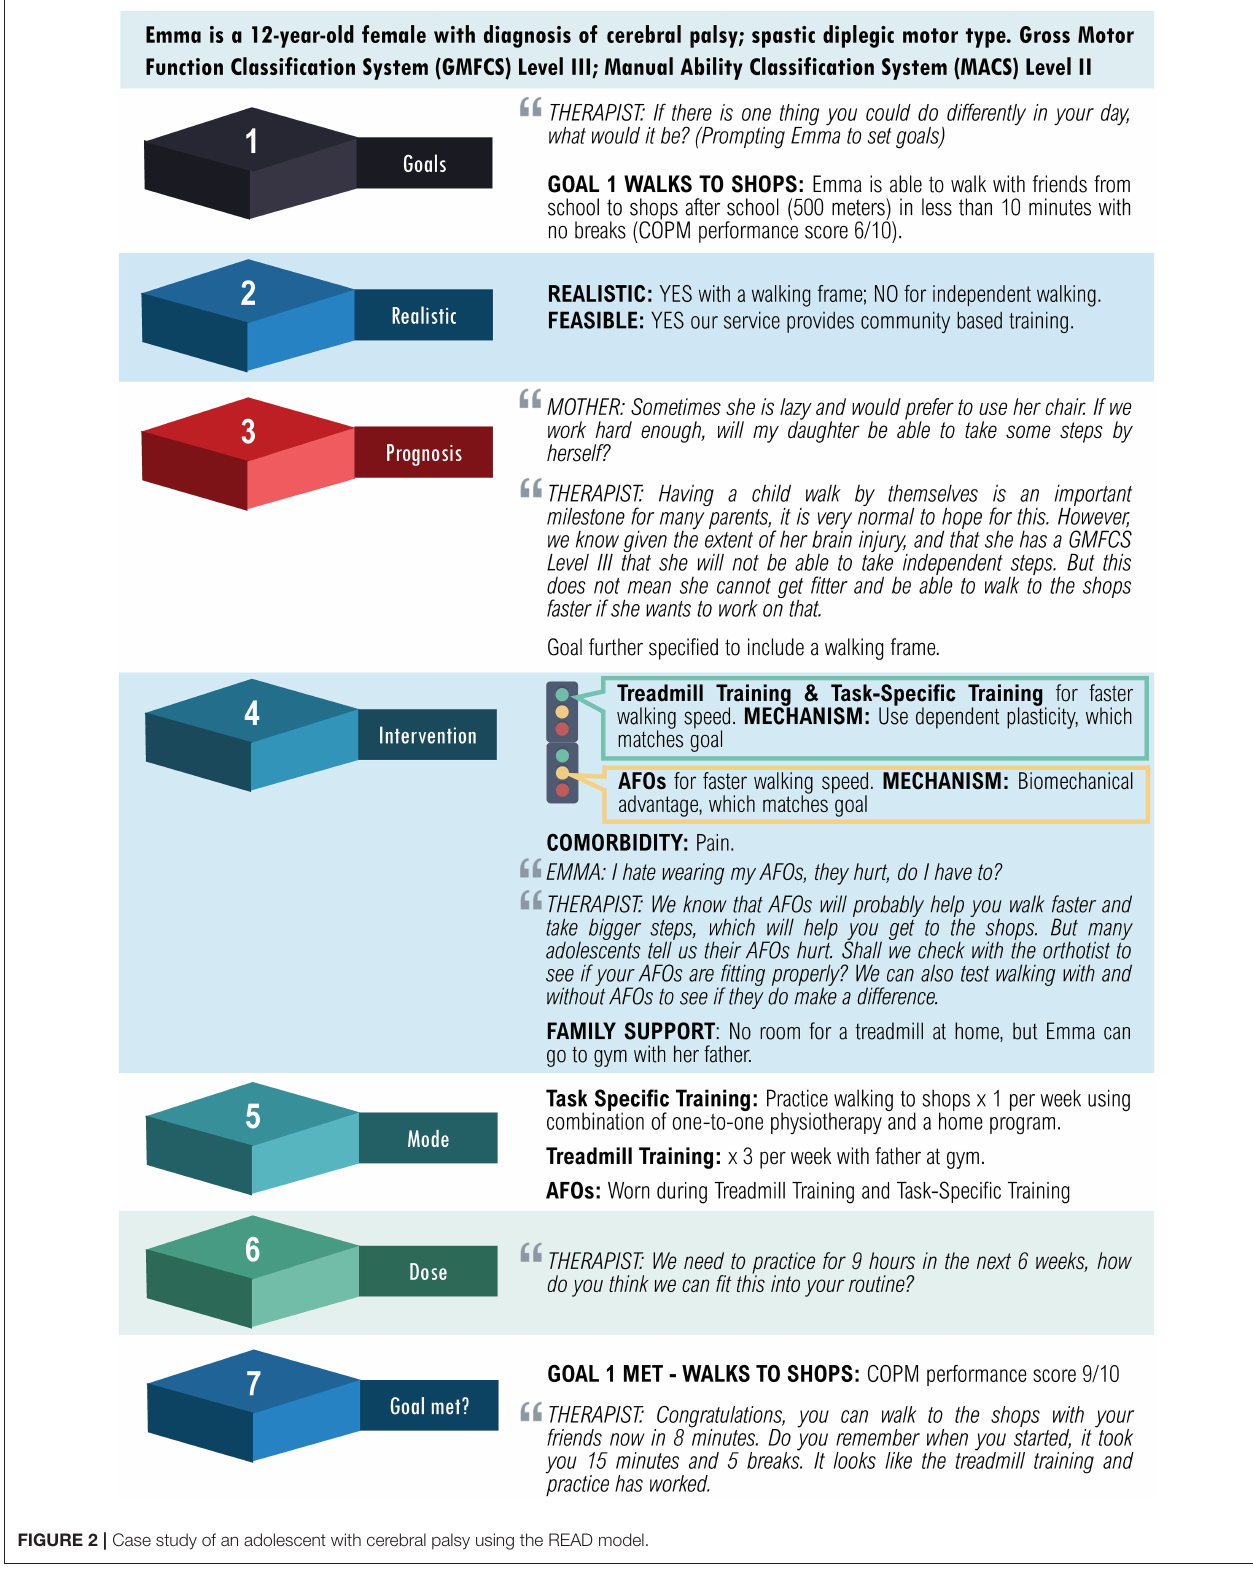
Frontiers in Rehabilitation Sciences |